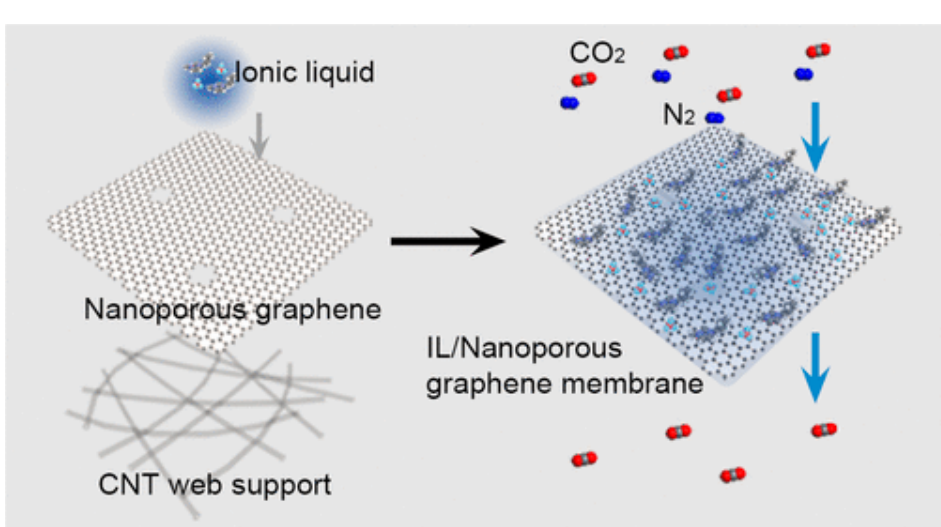
2 capture by NH 2